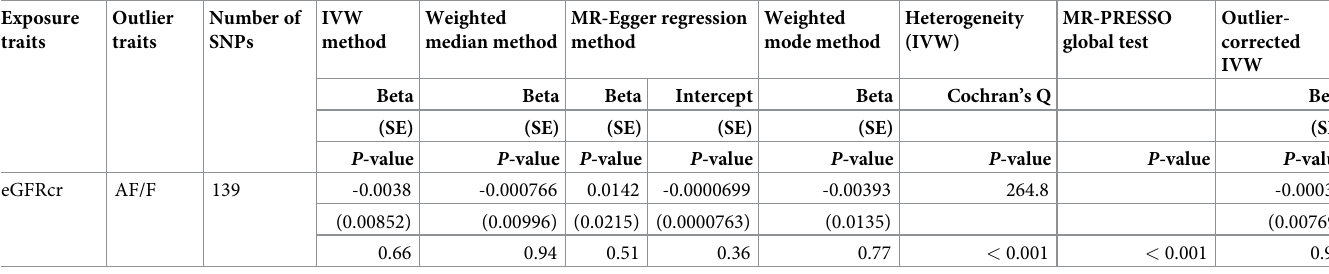
Table 2. MR results of the effect of the change of eGFRcr on the risk of AF/F. Exposure Outlier Number of traits traits SNPs